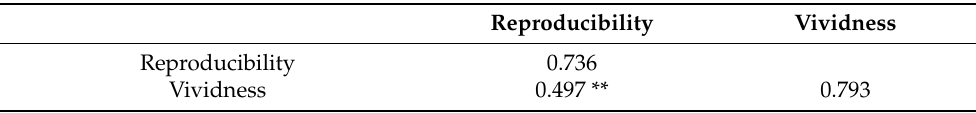
Table 5. Differential validity among variables of tourism experience